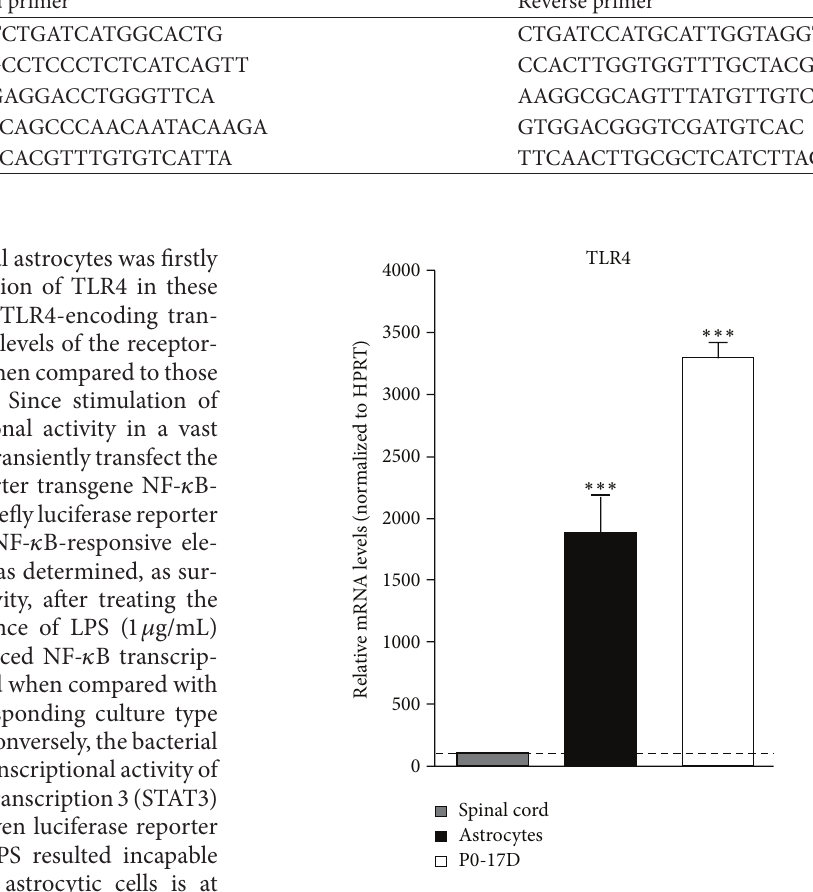
Figure 1: Comparative analysis of TLR4 expression in mouse spinal cord, P0-17D cell line, and primary spinal cord astrocytes. Expression of TLR4 was determined in mouse spinal cord, P0- 17D cells, or primary astrocytes. Total RNA was extracted, reverse- transcribed, and analyzed by RT-qPCR ( 𝑛 = 3 in duplicate). Values (mean ± s.e.m.) were normalized relative to HPRT and expressed as percentage of TLR4 mRNA levels in mouse spinal cord ( ∗∗∗ 𝑝 < 0.0001 versus mouse spinal cord; one-way ANOVA followed by Bonferroni post hoc